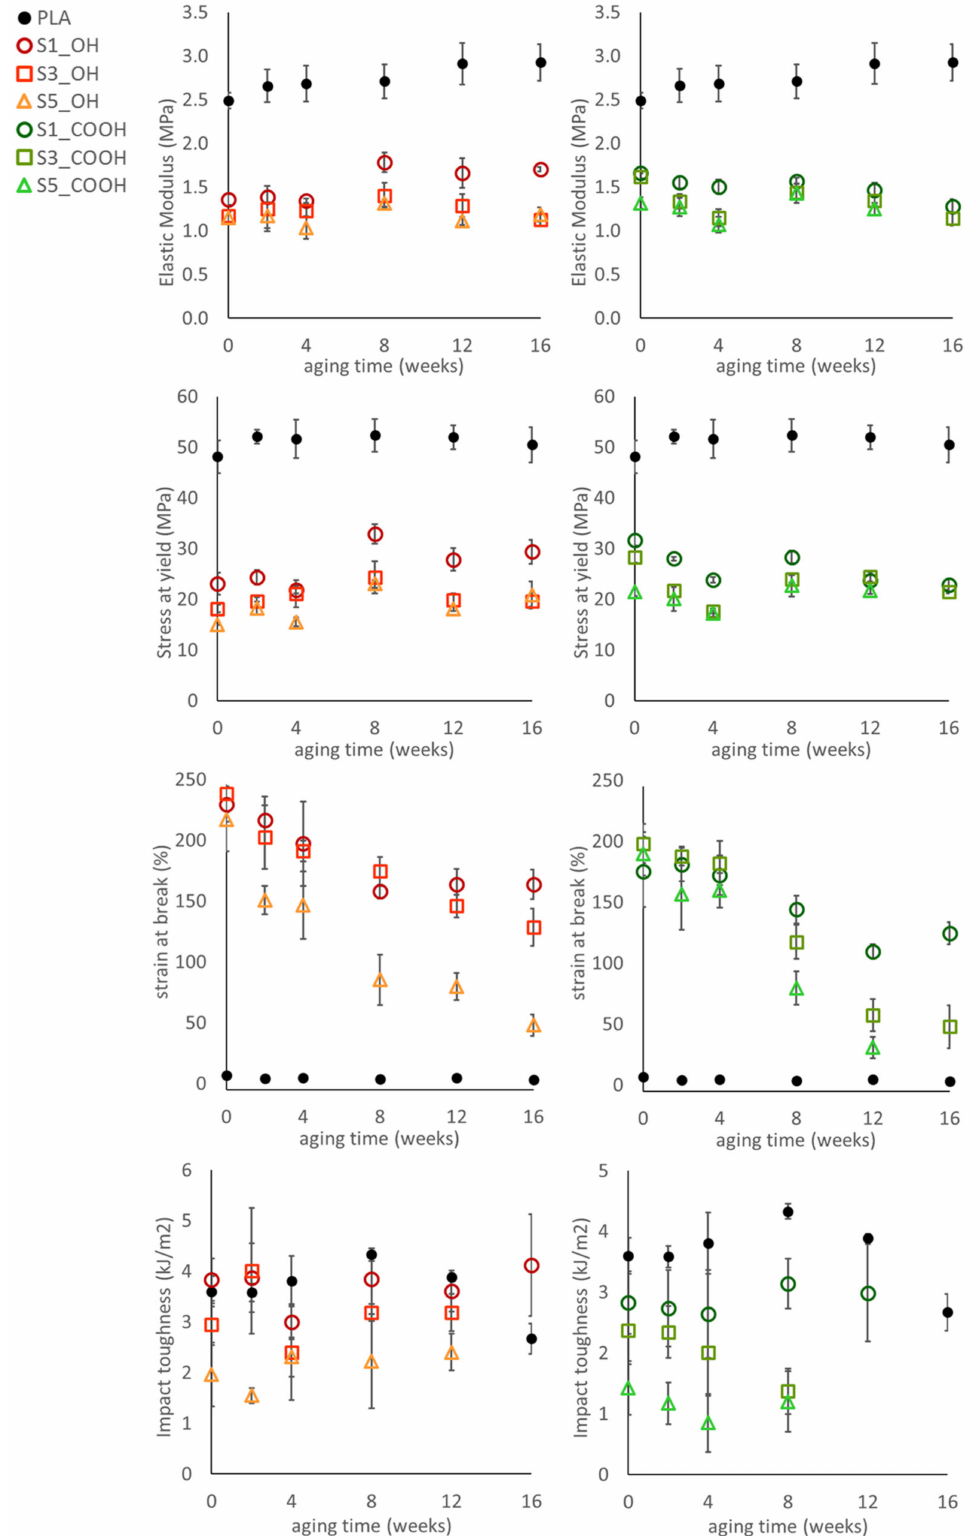
Figure 5. Evolution of the tensile and impact properties of the plasticized nanocomposites during